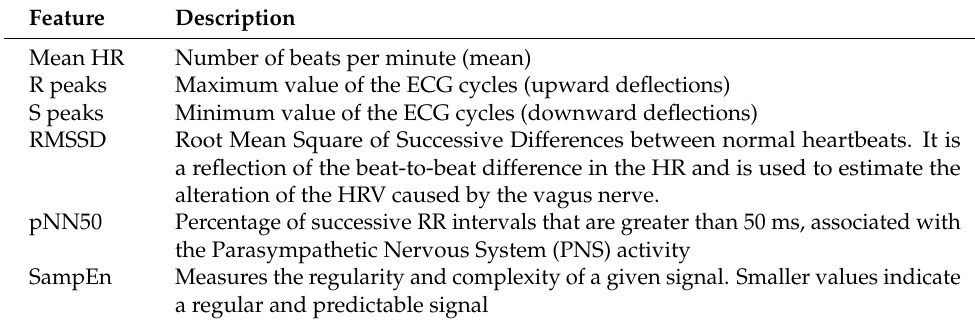
Table 1. Description of the extracted ECG